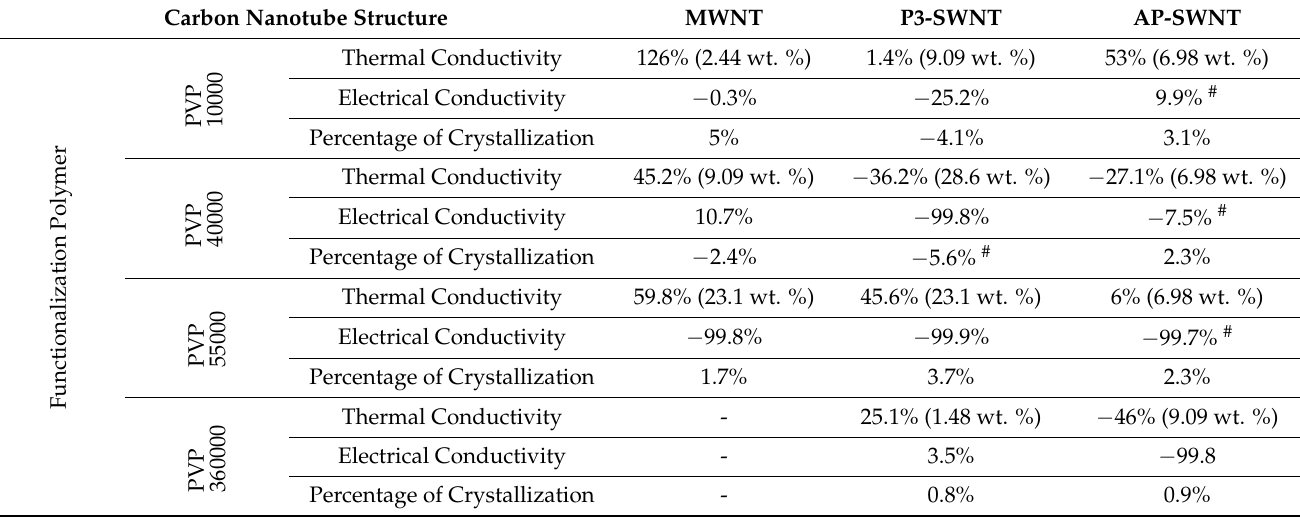
Table 1. Degree of enhancement/diminution in the thermal, electrical, and crystallization properties of the CNT-PVDF composite due to PVP functionalization of CNTs. The value provided for the thermal conductivity is the greatest enhance- ment observed. The number in brackets is the PVP concentration in weight percent at which this enhancement occurs. The electricity conductivity and % crystallization is provided for the same concentration for each